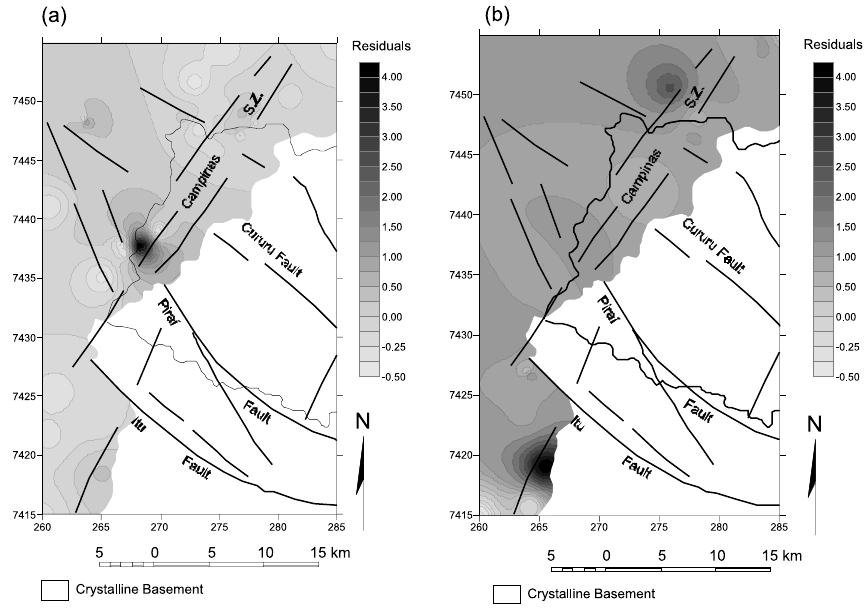
Fig. 7 – Residual map of specific capacity of wells that exploit (a) the Tubarão Aquifer System and (b) the wells that exploit both aquifers and the shear zones and regional